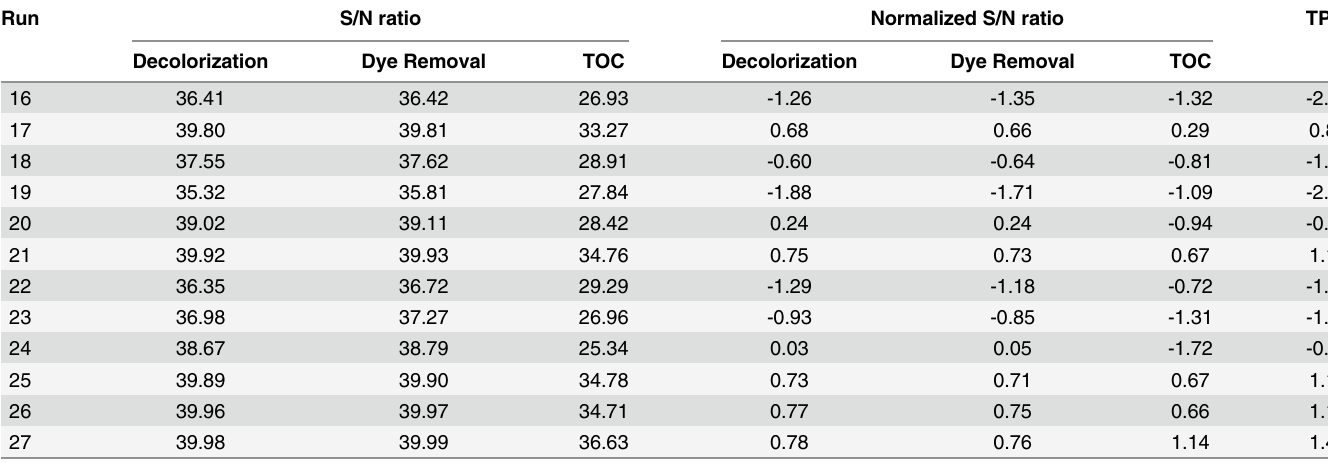
Table 8. The obtained S/N ratios, normalized S/N ratios, and TPCI values for run 16 to 27.